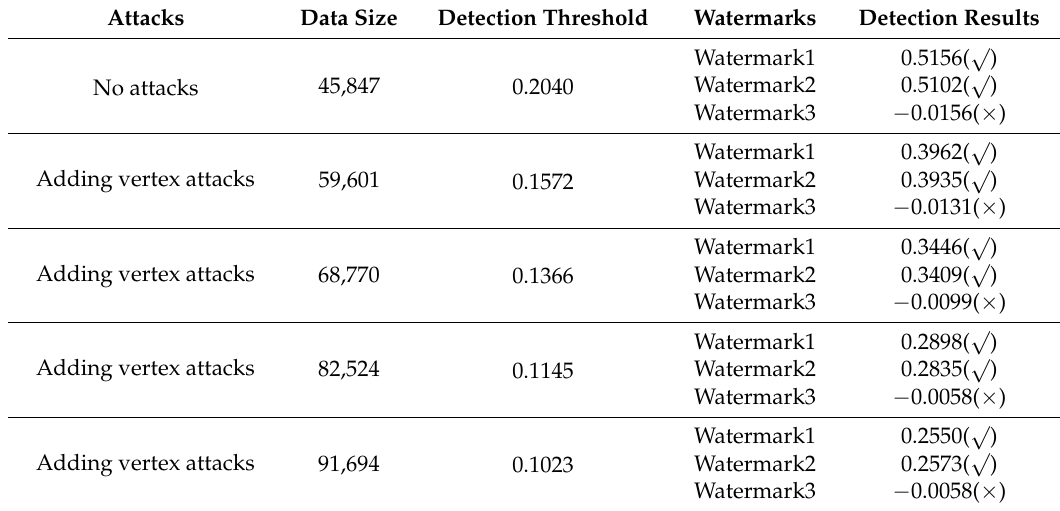
Table 2. The detection results after the random addition of vertices to the experimental data.